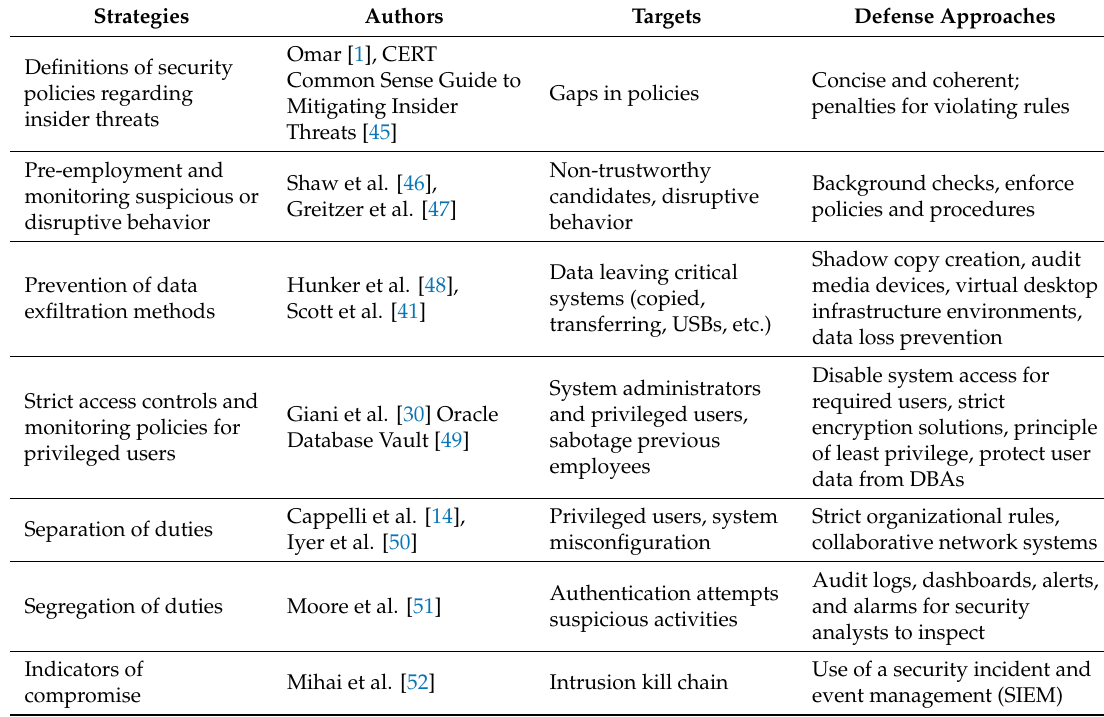
Table 2. Summary of defense